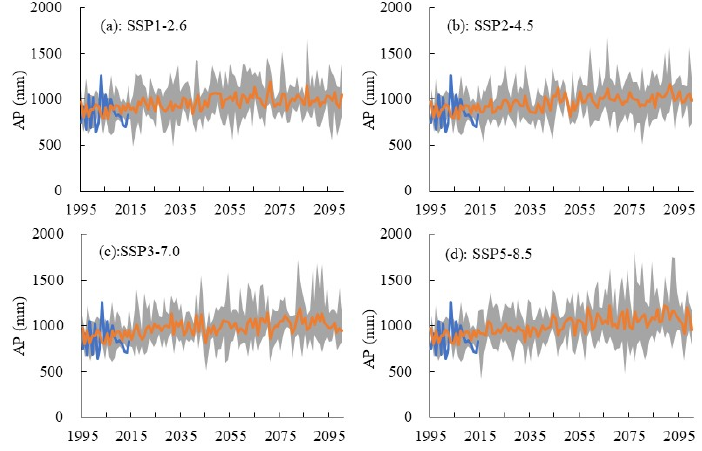
Figure 3. Historical variation and projection trend of AP under SSPs scenarios (a to d represent SSP1-2.6, SSP2-4.5, SSP3-7.0, and SSP5-8.5 respectively) for the Huai River basin (same to Figure 2).